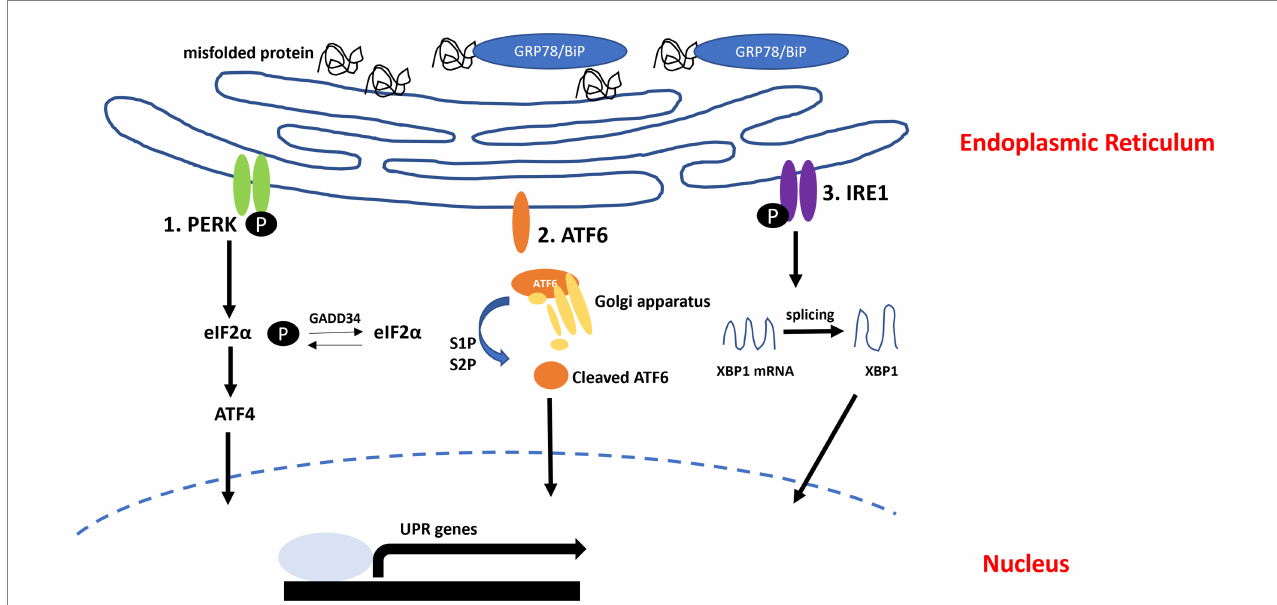
FIGURE 1 Unfolded protein response (UPR) pathway. In normal condition, GRP78/BiP interact with UPR sensors (PERK, ATF6, and IRE1). When misfolded or unfolded proteins accumulated in ER, GRP78/BiP dissociated from UPR sensors and can bind to misfolded or unfolded proteins. (1) Protein kinase RNA-like endoplasmic reticulum kinase (PERK) autophosphorylates and induces eIF2 α phosphorylation. (2) Activating transcription Factor 6 (ATF6) moves into Golgi apparatus and cleaved by S1P and S2P. Cleaved ATF6 moves into nucleus, activates UPR genes. (3) IRE1 autophosphorylates and splices